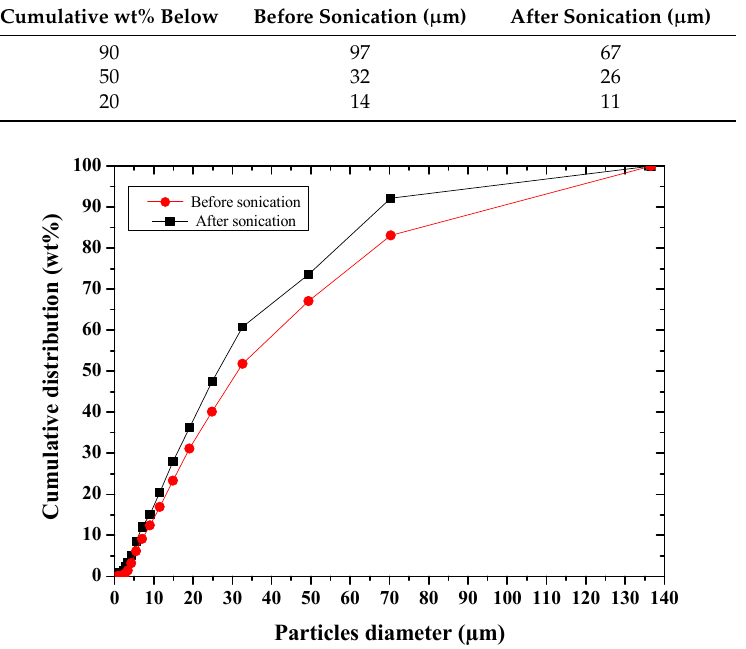
Table 1. Diameter in micron of glass ceramic powder before and after sonication.